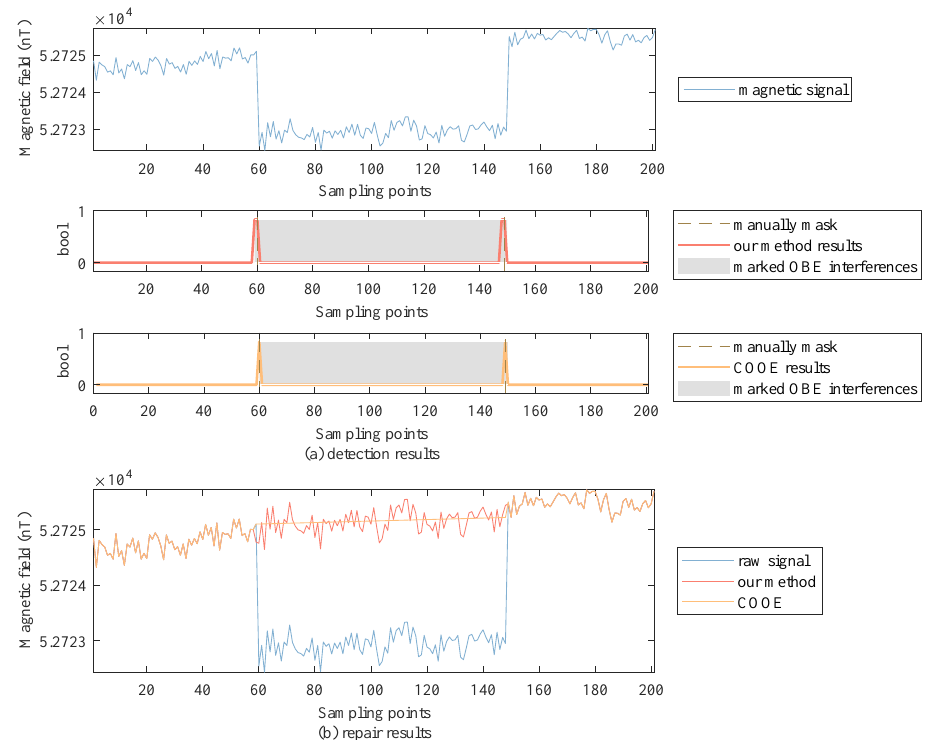
Figure 10. Detection and repair results of the aircraft’s radio